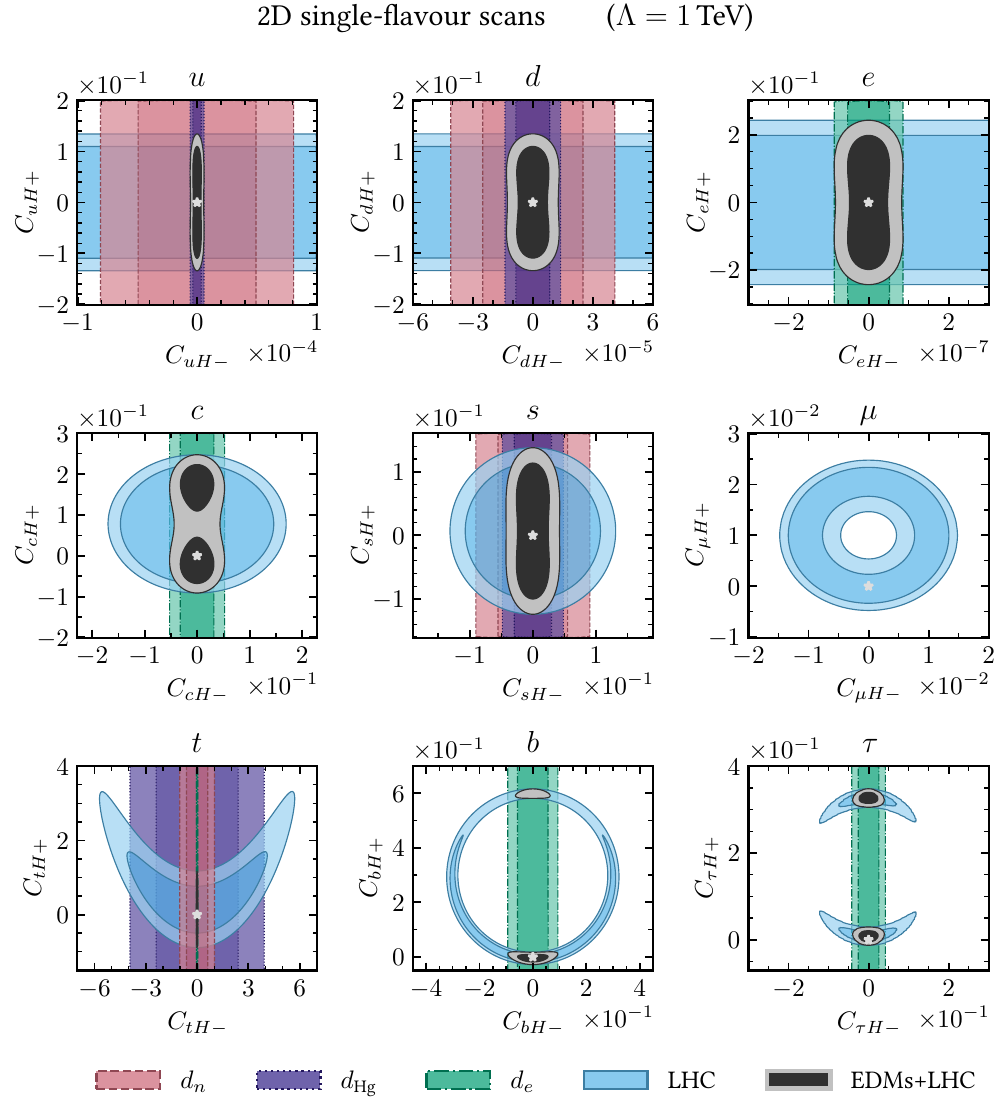
Figure 4 . EDM and LHC constraints on CP-even ( C fH + ) and CP-odd ( C fH − ) Higgs Yukawa couplings assuming Λ = 1 TeV. Each plot shows the result of a 2D scan in which only the two Wilson coefficients of the respective fermion are sampled. The contours represent the allowed 68% and 95% confidence regions for their respective observables. The colour coding of individual constraints is given in the legend, grey/black areas correspond to the regions allowed by the combination of all constraints. Regions allowed by an individual observable are only shown if the observable has a constraining effect on the parameter space. The sampled intervals are bounded by the perturbativity condition | C fH ± | ≤ 4 π